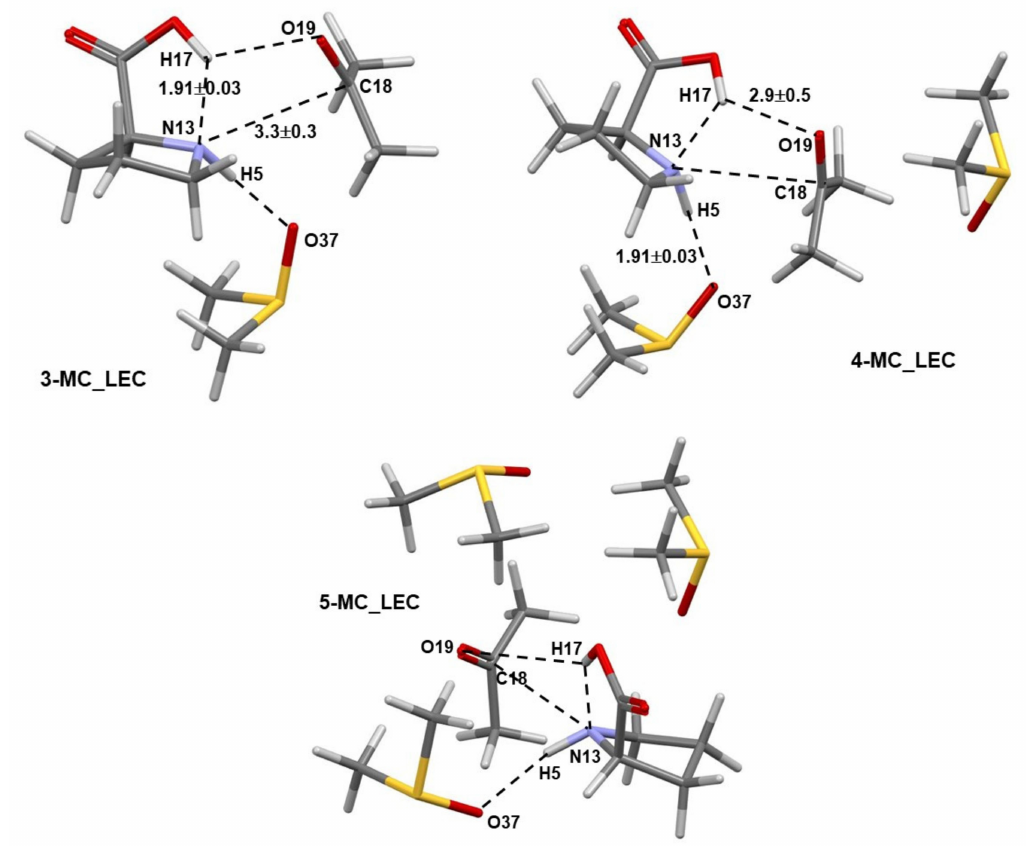
Figure 2. Selected averaged geometric distances with standard deviations (in Å) in the lowest energy and pre-organized (for the first step of the proline-catalyzed reaction with acetone) 3-MC, 4-MC, and 5-MC (found from conformation search in Spartan and energy-optimized in Gaussian) containing the lowest energy conformer (the LEC, 1a ) of proline 1